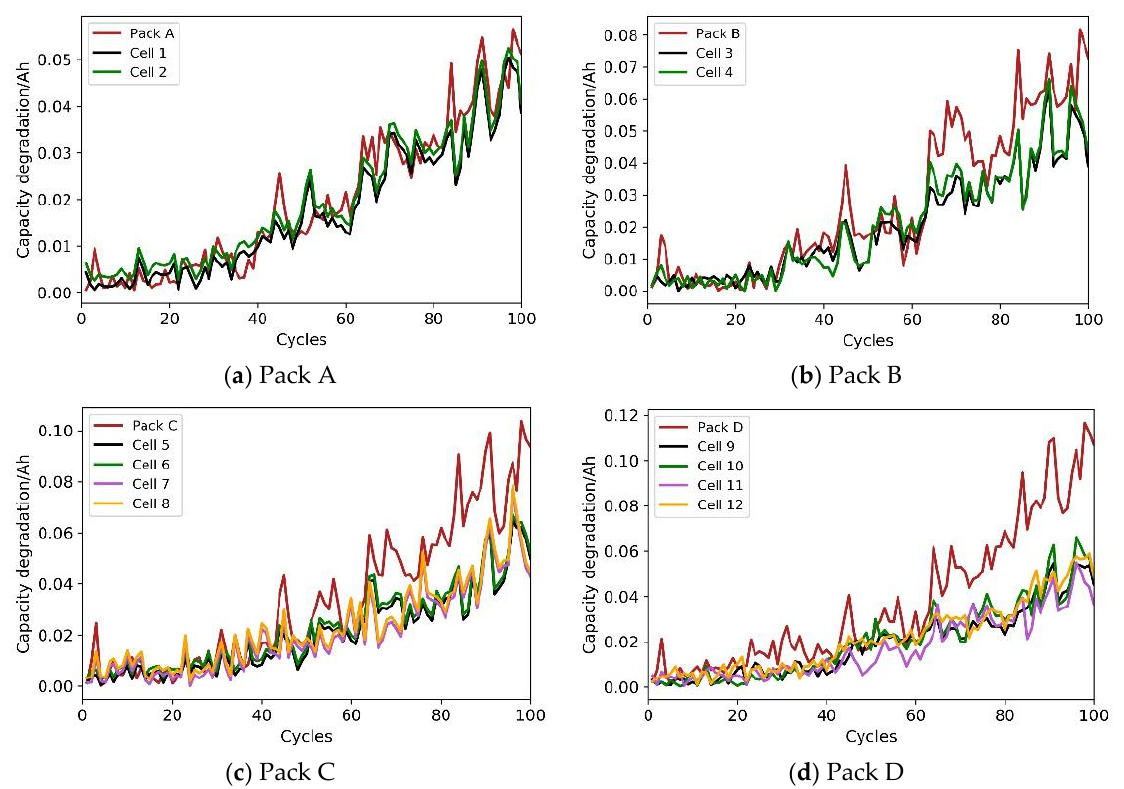
Figure 2. Capacity degradation increment curves of the four battery packs: ( a ) Pack A, ( b ) Pack B, ( c ) Pack C, ( d ) Pack D.